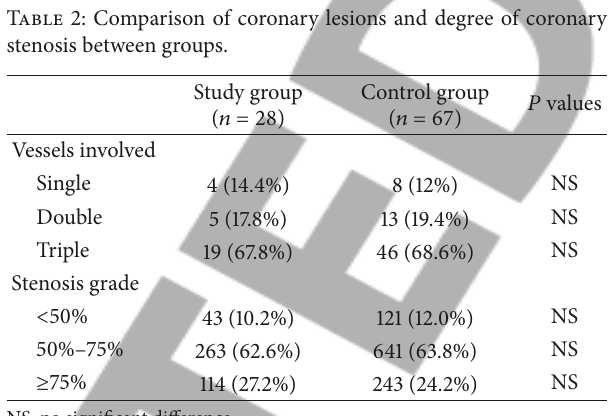
Figure 3: A 57-year-old female with an 11-year history of type 2 diabetes. Mixed plaque was showed in LAD with eccentric lesions with a narrow base and rough surface (black arrow).